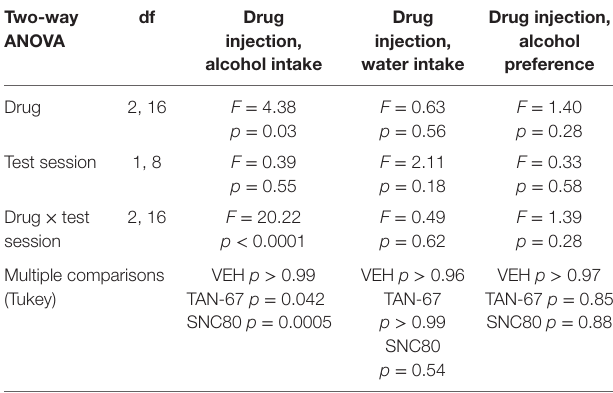
TaBle 2 | Two-way, repeated measures ANOVA of alcohol-related behaviors in wild-type mice upon biased delta-opioid receptor agonist infusion in the dorsal striatum.